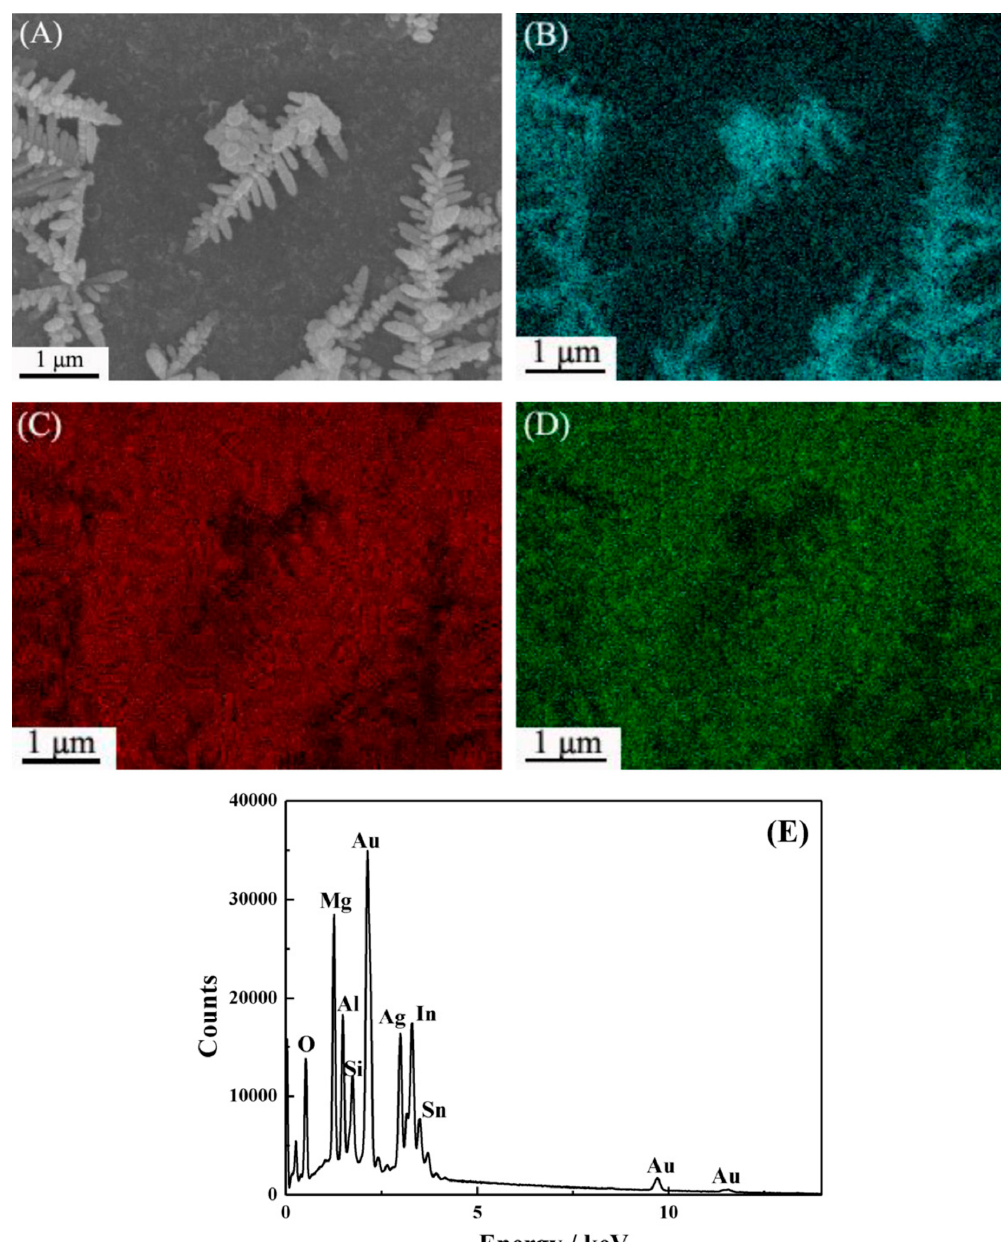
Figure 7. ( A ) SEM image of Ag/LDH/ITO and its corresponding elemental mappings for ( B ) Ag, ( C ) Mg and ( D ) Al. ( E ) the corresponding EDX spectrum taken from the whole area of ( A ). Images reproduced from [66] with permission.